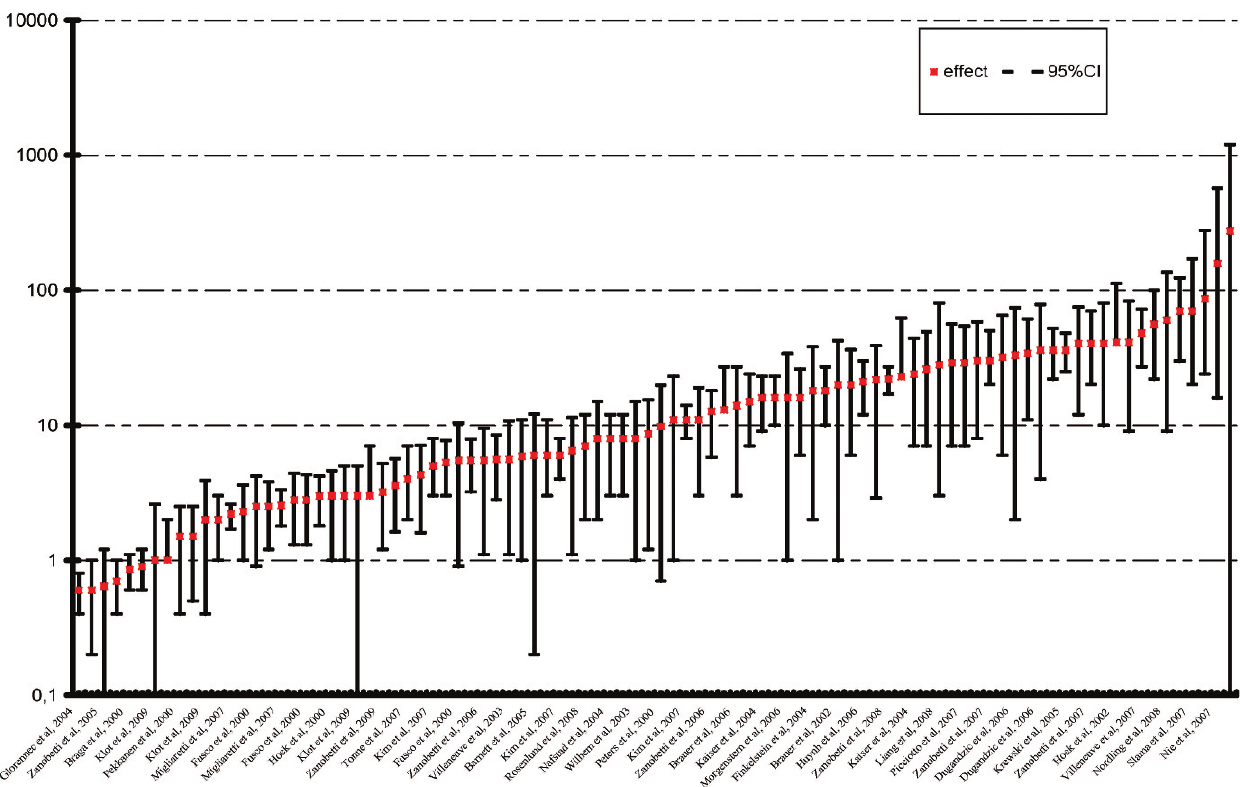
Figure 2 - Percentage increase interval (CI 95%) from selected non- Brazilian studies of air pollution and adverse human